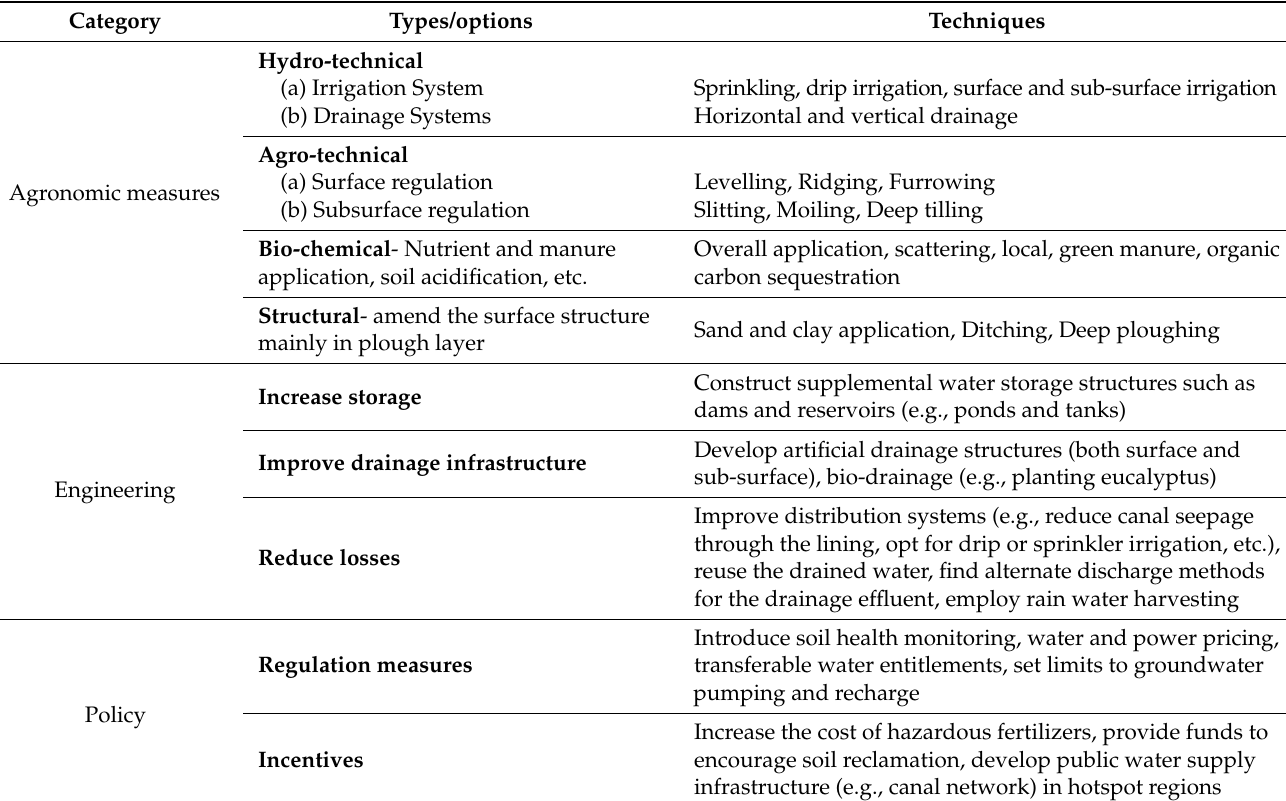
Table 2. Mitigation options for salinity and sodicity hazard (Adapted from Vargas et al., 2018 [125]).